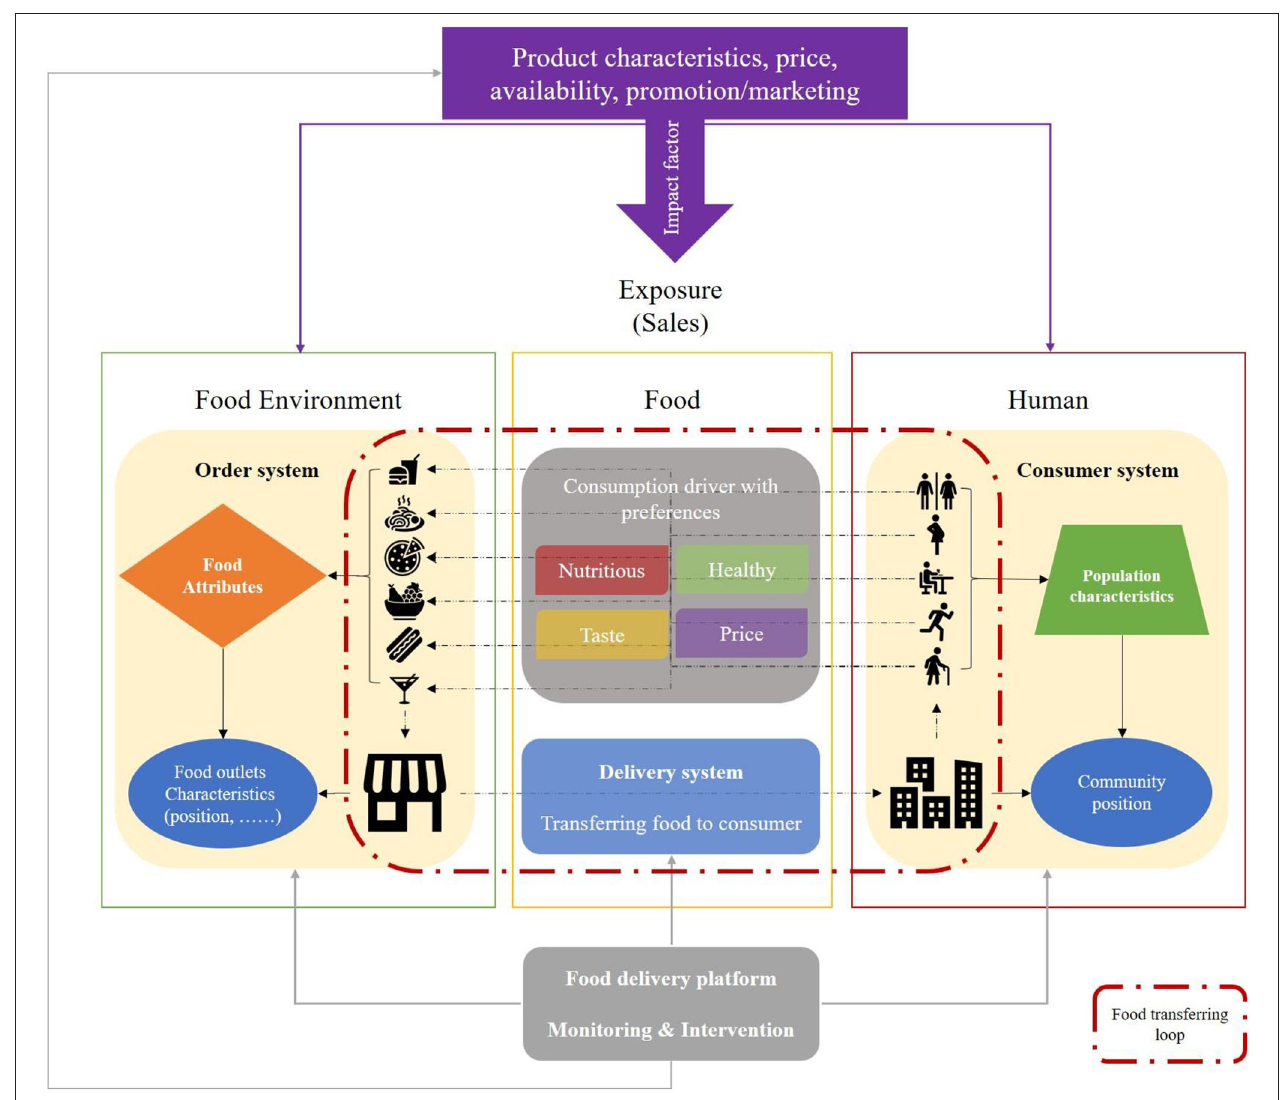
FIGURE 2 | An analytical framework of the online public food